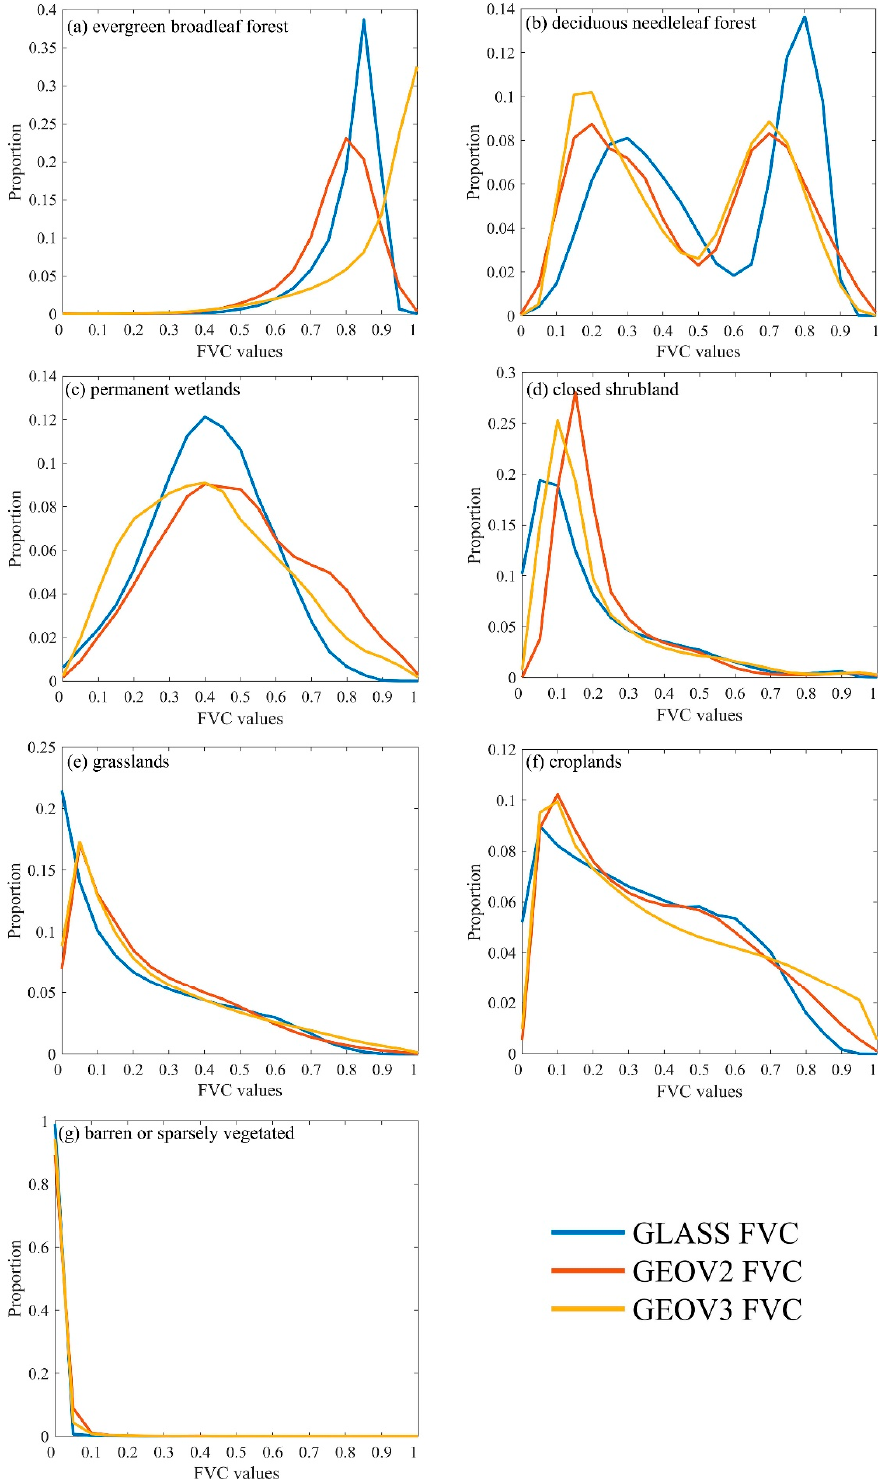
Figure 3. Histograms of GEOV2, GEOV3, and GLASS FVC products from 2014 to 2016 with different vegetation types.